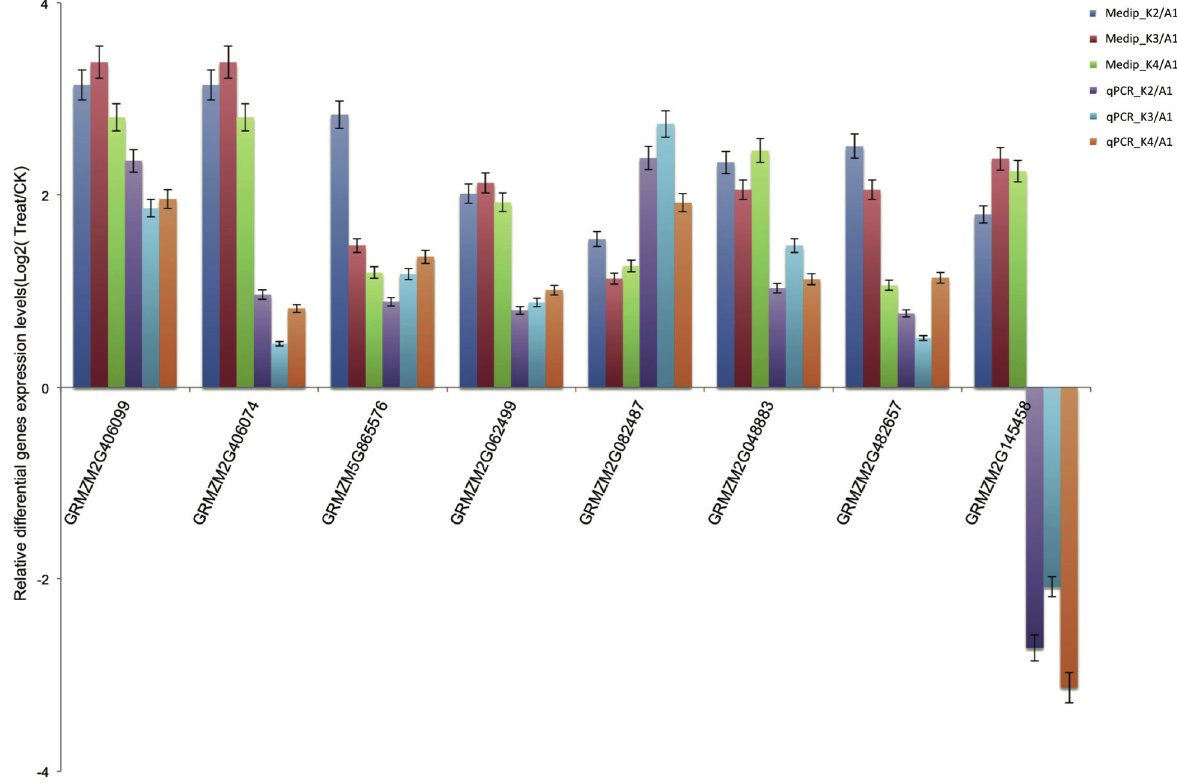
Figure 4. qRT-PCR validation of the Medip-seq data. log2-fold change determined from the relative C t values of 8 genes were compared with those detected by Medip-seq. Three replicates for each sample were run and the C t values averaged. All C t values were normalized to 18s